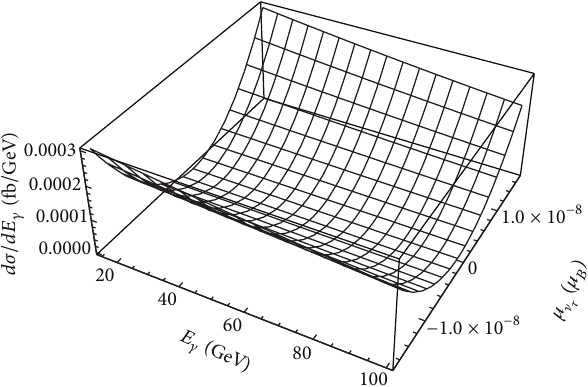
Figure2:Thedifferentialcrosssectionfor 𝑒 + 𝑒 − → ]] 𝛾 asafunction . of 𝐸 𝛾 and 𝜇 ] 𝜏